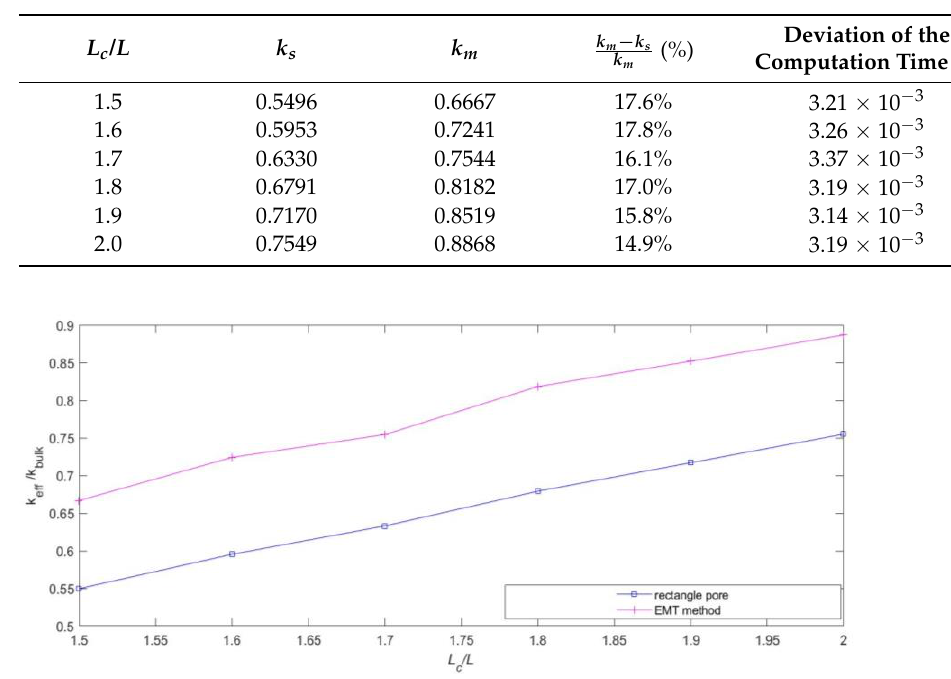
Figure 7. The effective thermal conductivity with the EMT method and the MCBU method with the changes of L c / L in rectangle pores.